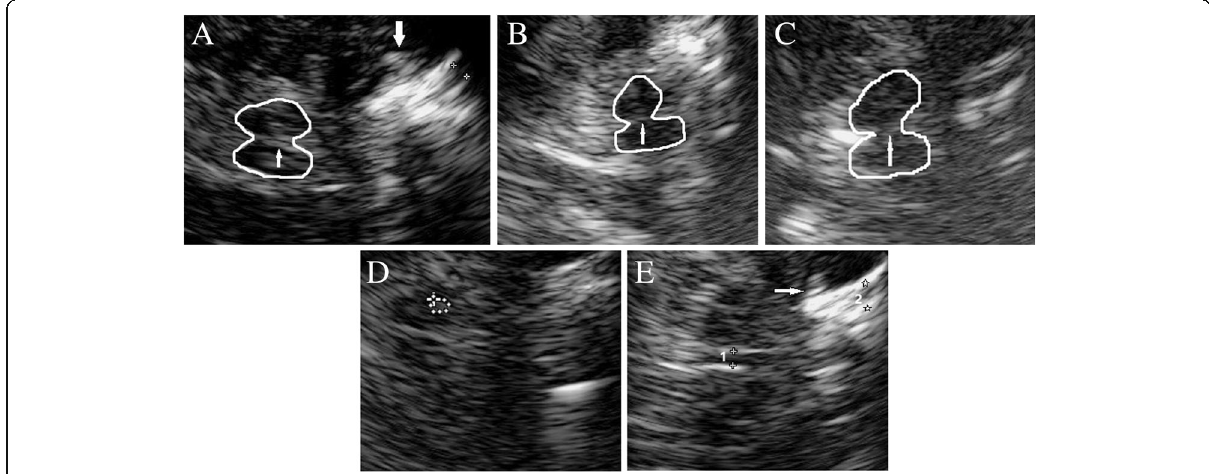
Fig. 1 TCS images of mesencephalic ( a , b , c , d ) and diencephalic plane ( e ). a Normal echogenicity of BR (thin arrow), grade 2; thick arrow indicates hyperechogenicity of LN. b Pathologic echogenicity of BR, the echogenic line of the raphe appears abnormally slight and thin, grade 1. c Pathologic echogenicity of BR, the raphe is not visible, grade 0. d Normal echogenic area of SN. e Hyperechogenicity of CN (thin arrow), width of the frontal horn of the lateral ventricle (2) and of the third ventricle